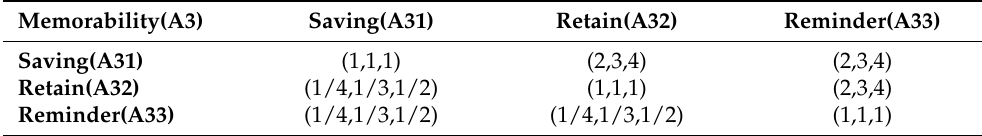
Table 7. Fuzz-based comparison matrix associated with the sub-criteria in relation to the memorability (A3) criteria.